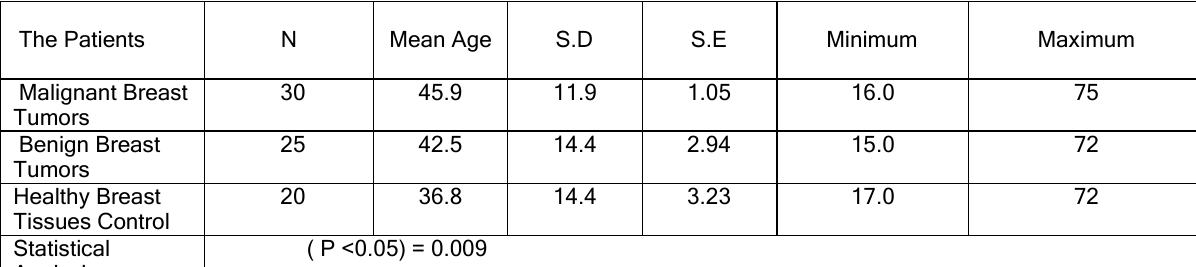
Table (1): Distribution of breast tumor patients according to their age